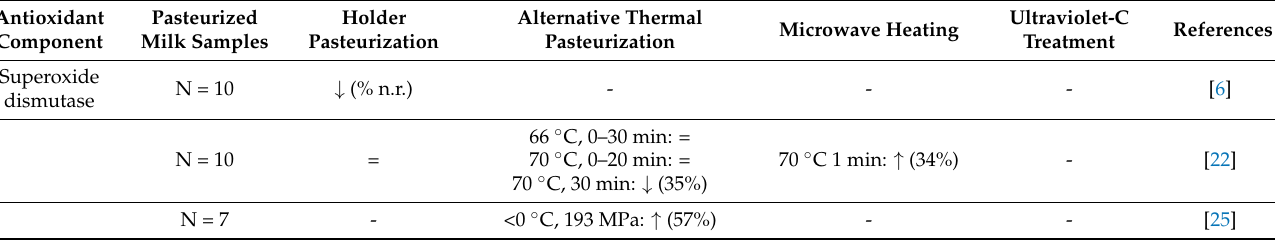
Table 2. Results of different pasteurization methods on antioxidant properties in human milk: enzymatic antioxidants. Antioxidant Pasteurized Component Milk Samples Superoxide